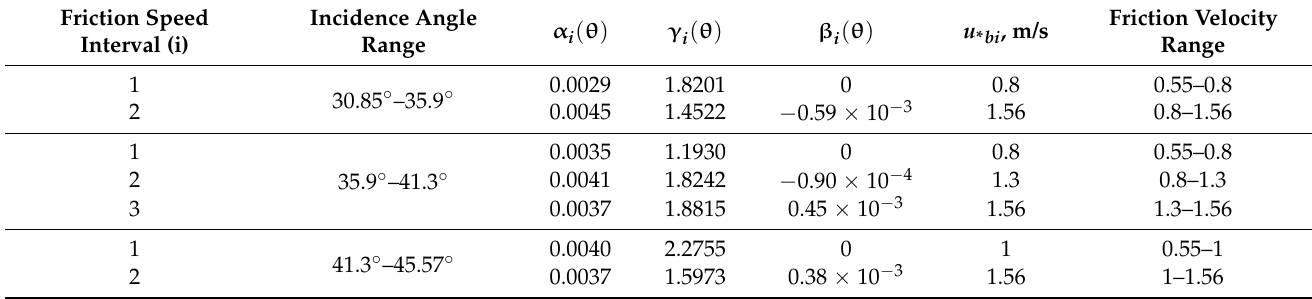
Figure 7 illustrates the dataset for the NRCS versus the friction velocity values ob- tained using expression (7). The dataset is limited with a cutoff value for equal to 1.56, which corresponds to the NRCS value of −21.4 dB. This cutoff is obtained due to the saturation effect observed for the dependency of ocean emissivity E w on the friction ve- locity for the values of E w exceeding 0.055 (see expression (7)). values of E w exceeding 0.055 (see expression (7)).